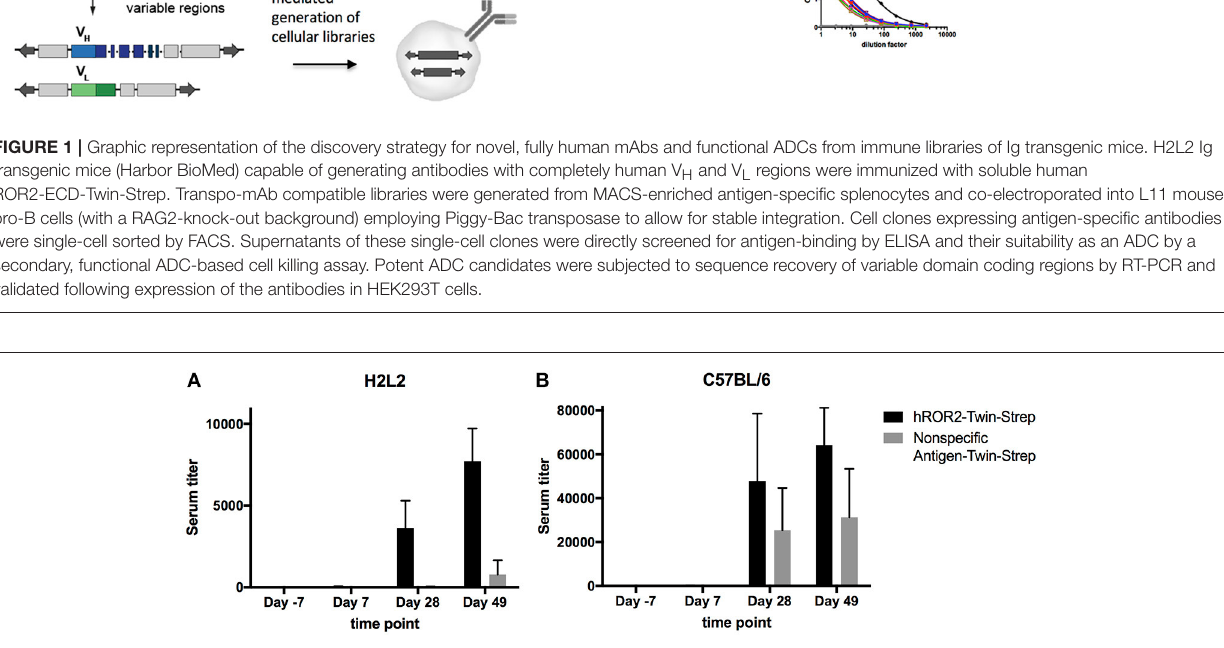
FIGURE 2 | hROR2-specific serum titers in H2L2 transgenic and in C57BL/6 wild-type mice. Five H2L2 Ig transgenic mice (A) and 5 wild-type C57BL/6 mice (B) were immunized with soluble hROR2-ECD-Twin-Strep. Serum samples were collected 7 days prior to immunization as well as on days 7, 28, and 49 post-immunization, i.e., always 7 days following each immunization. Titers in serum against hROR2-ECD-Twin-Strep as well as an unrelated soluble antigen also containing the same Twin-Strep-tag (Nonspecific Antigen-Twin-Strep) to assess tag-related responses were analyzed by ELISA. Bar graphs show mean values with standard deviation